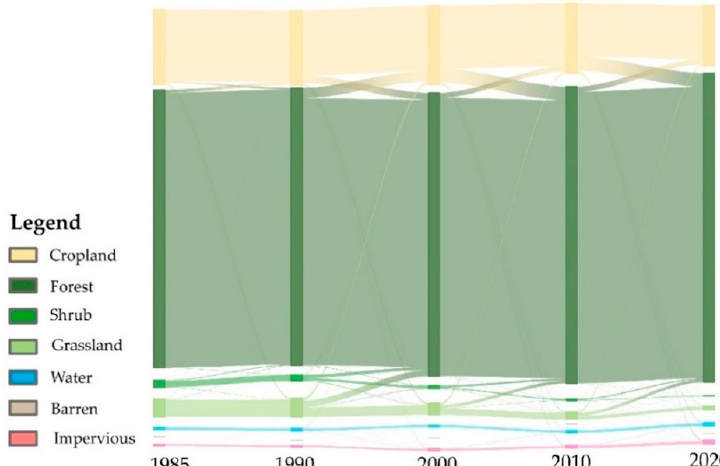
Figure 5. Transfer of land types in water source region from 1985 to 2020.